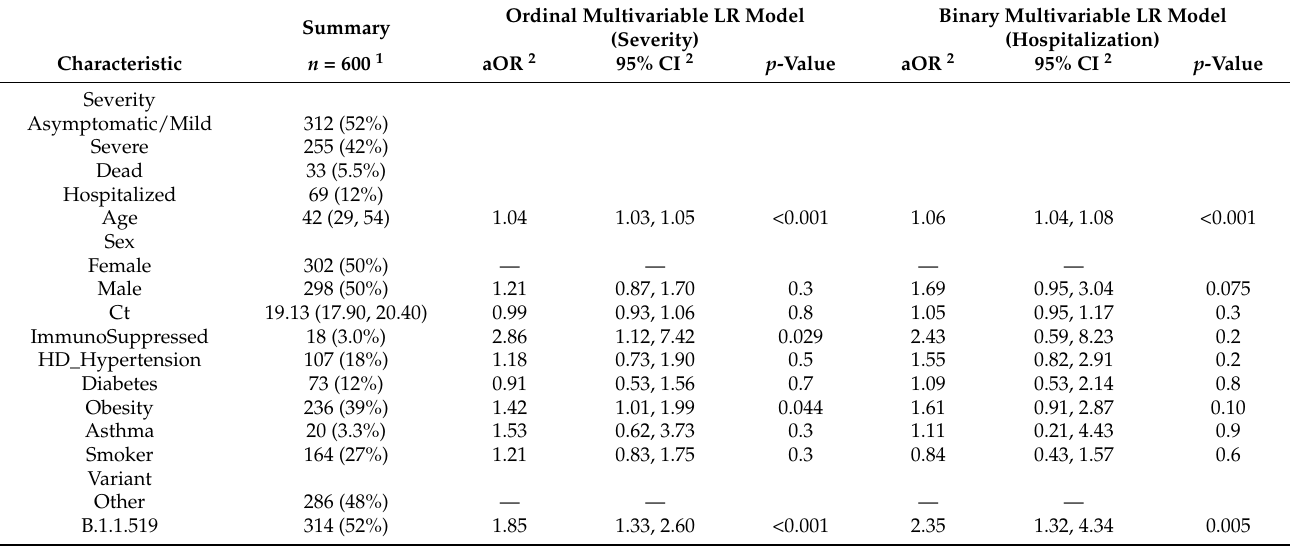
Table 2. Association of the SARS-CoV-2 B.1.1.519 variant with disease severity and hospitalizations. The severity outcomes were coded as 0 = Asymptomatic/Mild, 1 = Severe, or 2 = Dead; an ordinary multivariate LR model was fitted adjusted for covariates. A binary multivariate LR model was fitted for hospitalization.